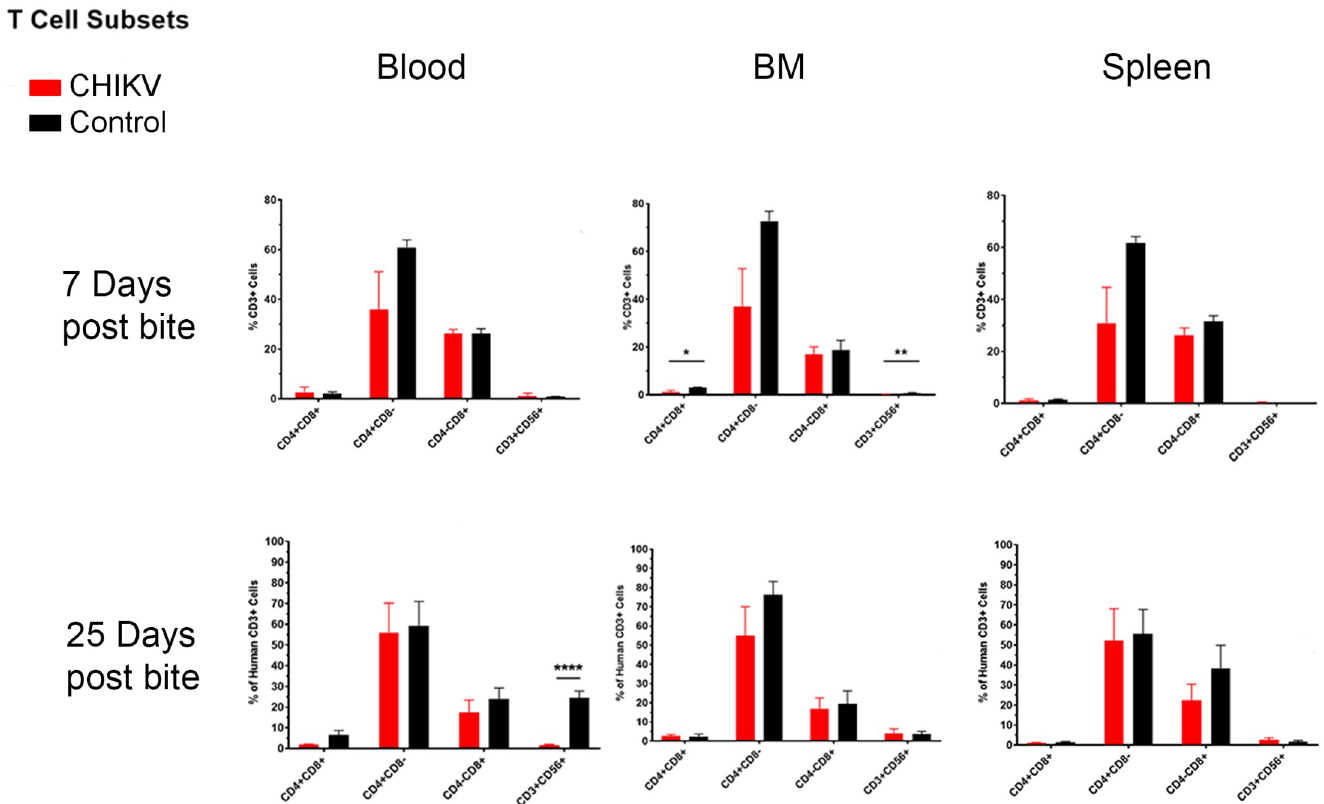
Fig 8. Summary of significant flow cytometry results (T cell subsets: Double positive T cells and NK T cells) comparing Hu-NSG mice bitten by infected mosquitoes versus those bitten with control (uninfected) mosquitoes. Hu-NSG mice were infected with CHIKV via mosquito bite. At 7 and 25 days post-infection, mice were euthanized, and changes in immune cell populations in the blood, spleen, and bone marrow between infected and control mice were assessed via flow cytometry. Outliers were removed via ROUT analysis, and statistical significance was assessed via multiple comparison t-test using the Holm-Sidak correction. Immune components are outlined in the graphs above and summarized in table 5. Asterisks indicate significance differences (n.s. = not significant; � p < 0.05; �� p < 0.01; ��� p < 0.005).